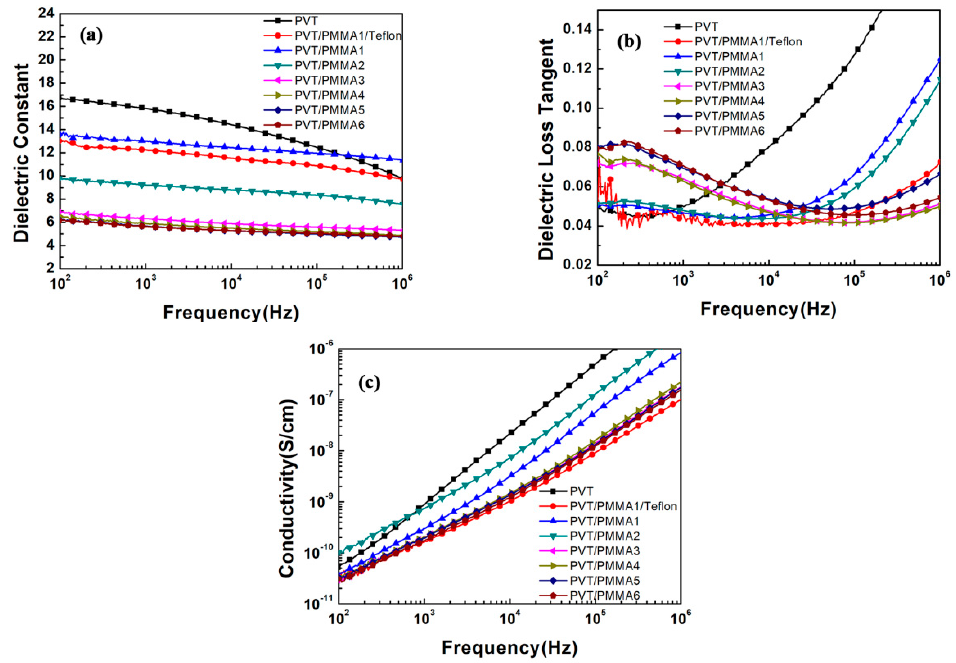
Figure 6. Frequency dependence of the ( a ) dielectric constant, ( b ) dielectric loss, and ( c ) electric conductivity of pristine P(VDF-TrFE) and PVT/PMMA blends at room temperature.